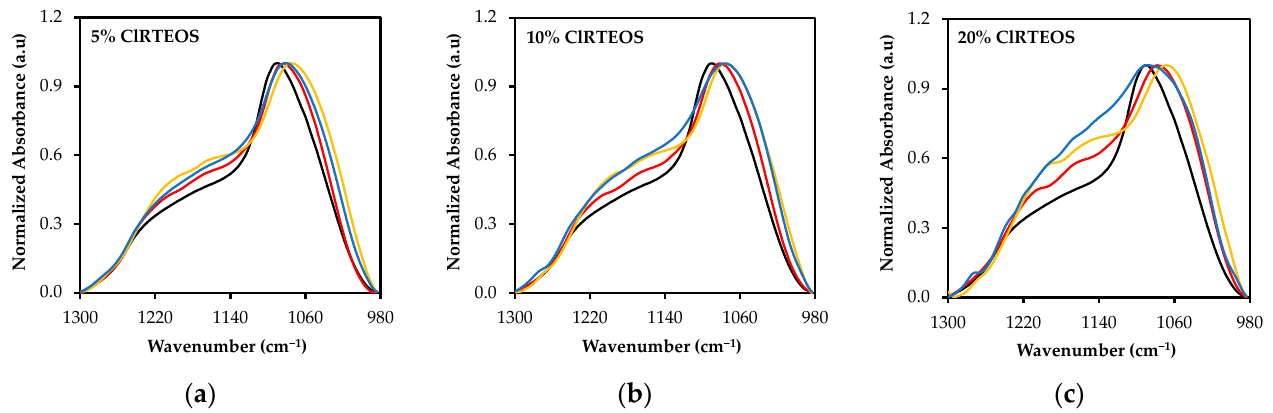
Figure 5. Normalized FTIR spectra of the 1300–980 cm − 1 region of the TEOS xerogel (black), and those of the three chloroalkyl series at different molar ratios: ( a ) 5%, ( b ) 10%, and ( c ) 20%. (ClMTEOS (red), ClETEOS (yellow), and ClPTEOS (blue)).